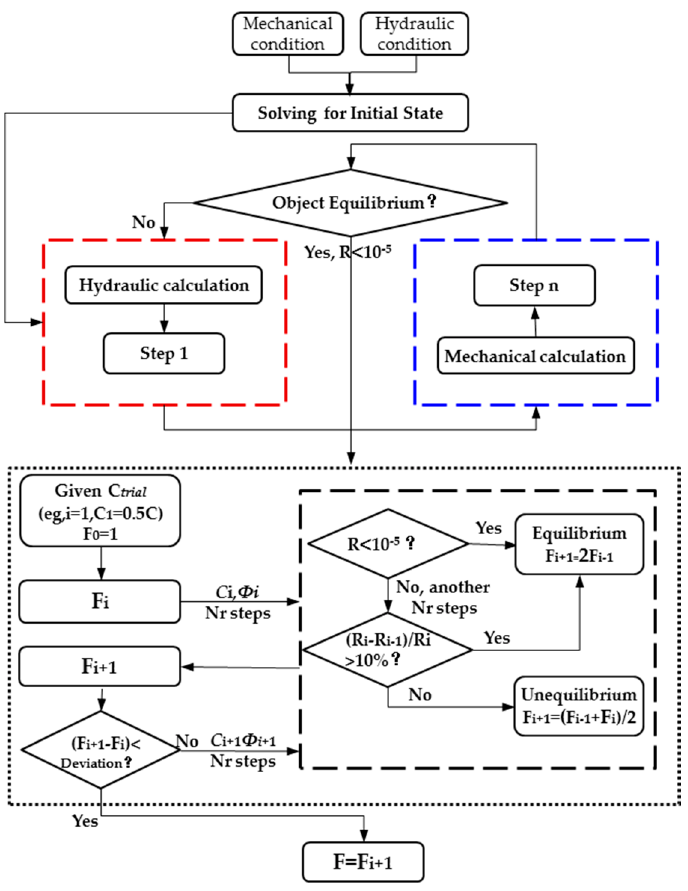
Figure 2. The solution process of safety factor in hydraulic-mechanical coupling with strength reduction method in the discrete-element method (DEM). n, the number of mechanical step per each fluid step and the number of fluid step per each mechanical step can be set by the users. R, the unbalanced force ratio (10 − 5 by default): The ratio of unbalanced force to the mean absolute value of force exerted by each surrounding zone, the unbalanced force is the net force acting on a grid point. Nr, characteristic response time, a representative number of steps (maximum limit of 50,000) that characterizes the response time of the system.